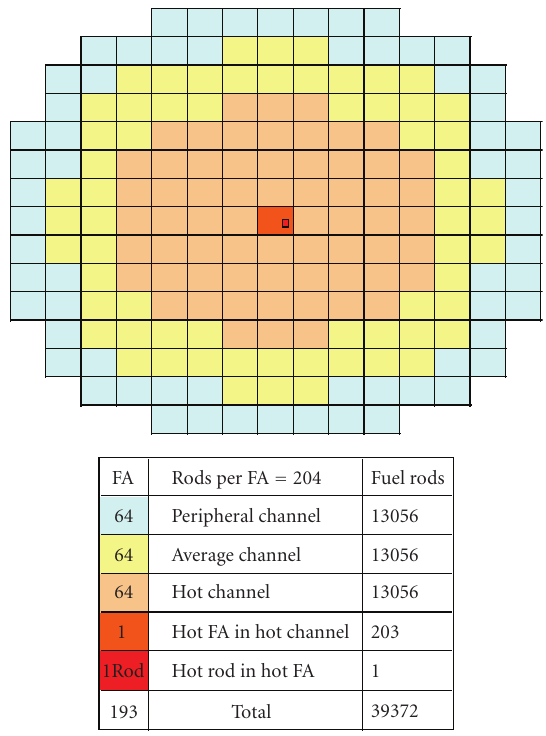
Figure 1: Core heat